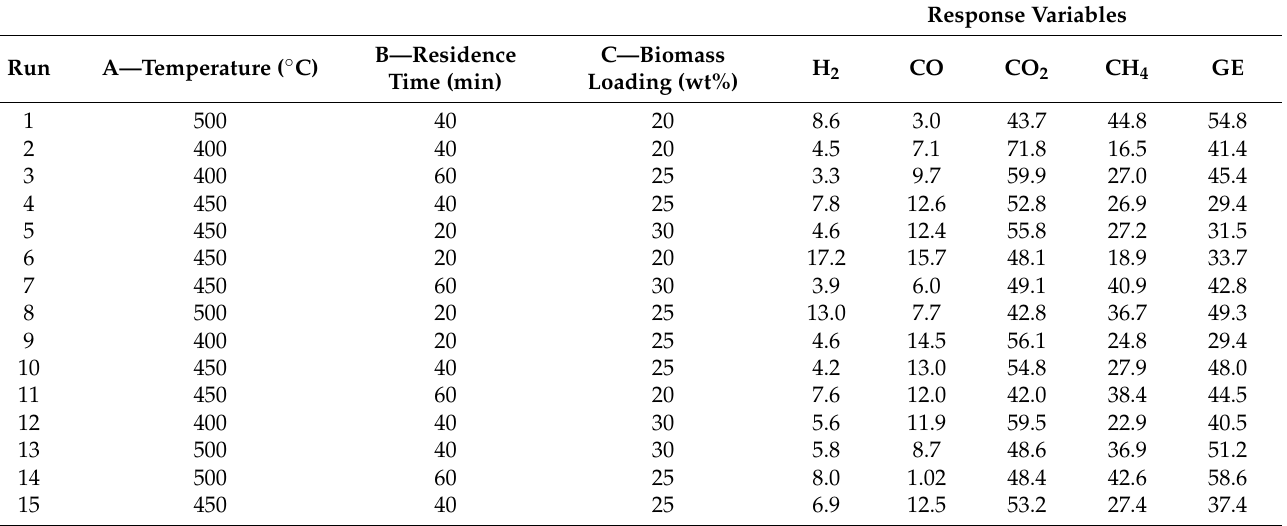
Table 8. Gaseous product characteristics for supercritical water gasification of impregnated coconut shell